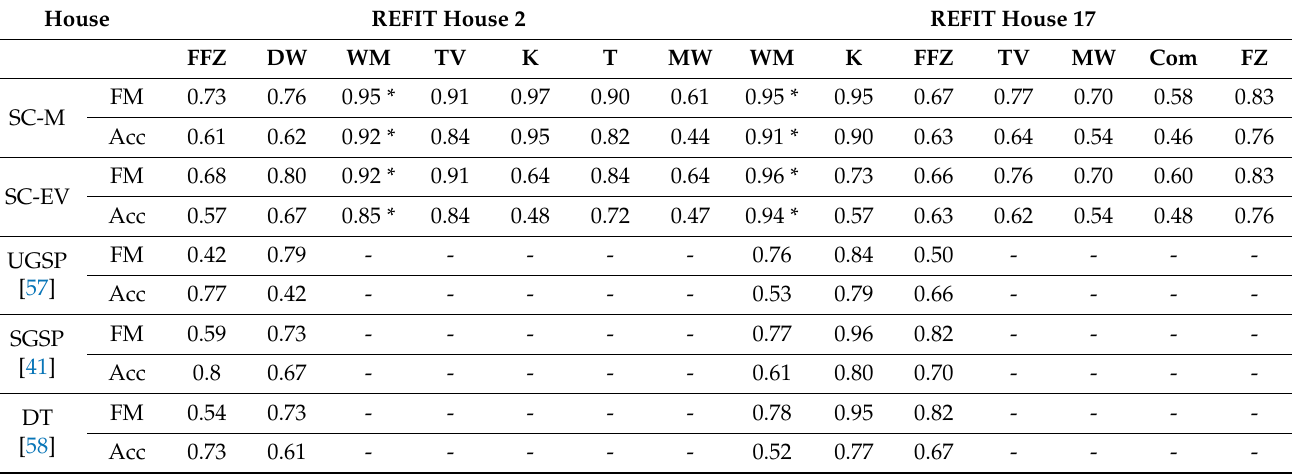
Figure 12. REFIT dataset House 8 comparison with results (accuracy). Table 6. Comparison between proposed and state of the art methods in